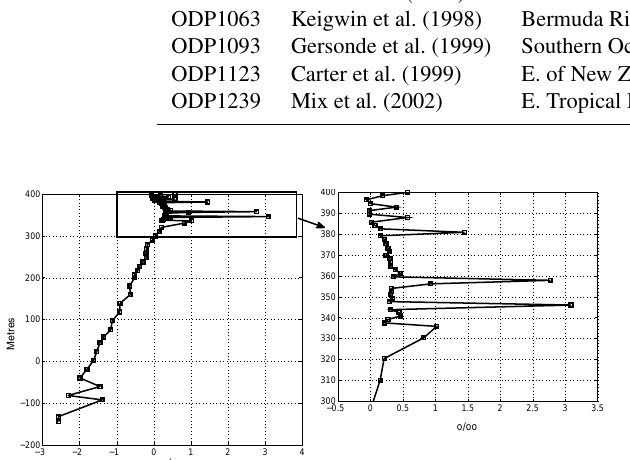
Figure 5. Measured salinity minus 35gkg − 1 (blue solid curves) and δ 18 O w (red dashed) in four cores. With the possible exception of core 1093 in the upper 100m, the two data sets are quite distinct and hence inconsistent with a common advection–diffusion equa- tion and boundary and initial conditions. The zero is set arbitrarily at